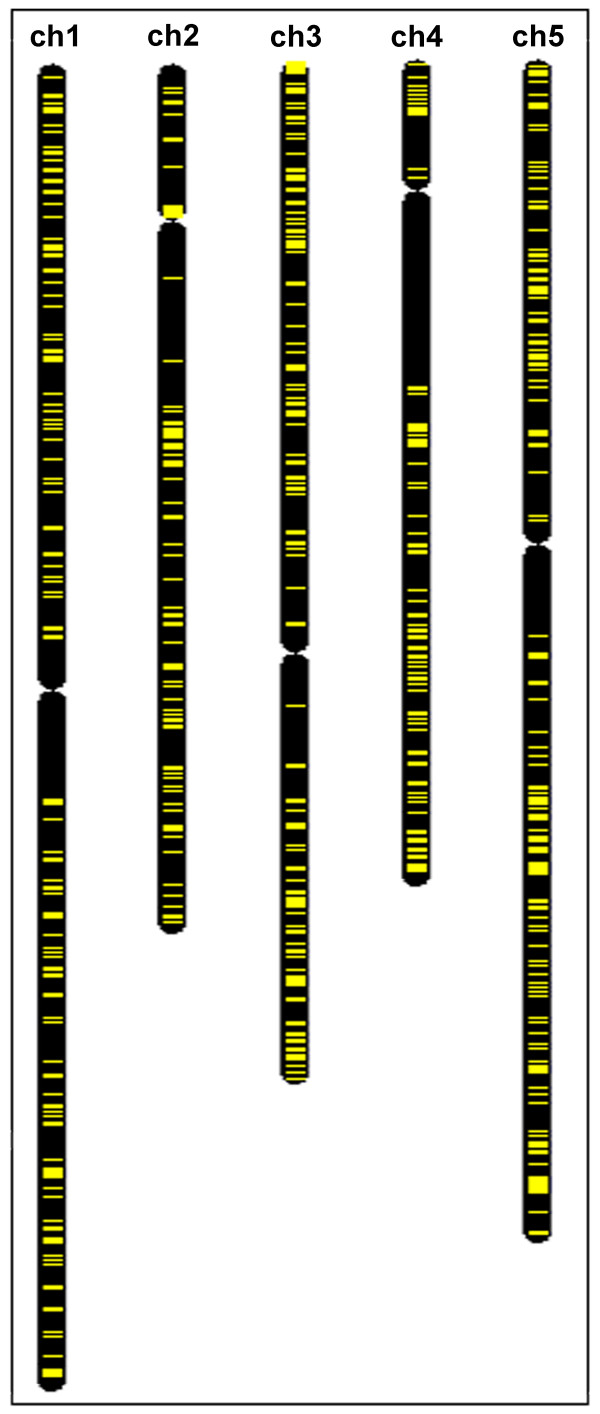
Coexpressed neighboring genes are absent from the region of long arm of chromosome 4. Distribution of the coexpressed neighboring genes (marked in yellow) on five Arabidopsis chromosomes (visualized in Chromosome Map Tool, [126,115]). Domains of coexpressed neighbors are absent from large part of the long arm of chromosome 4, adjacent to the pericentromeric region, and very rare in the analogous area of chromosome 2.